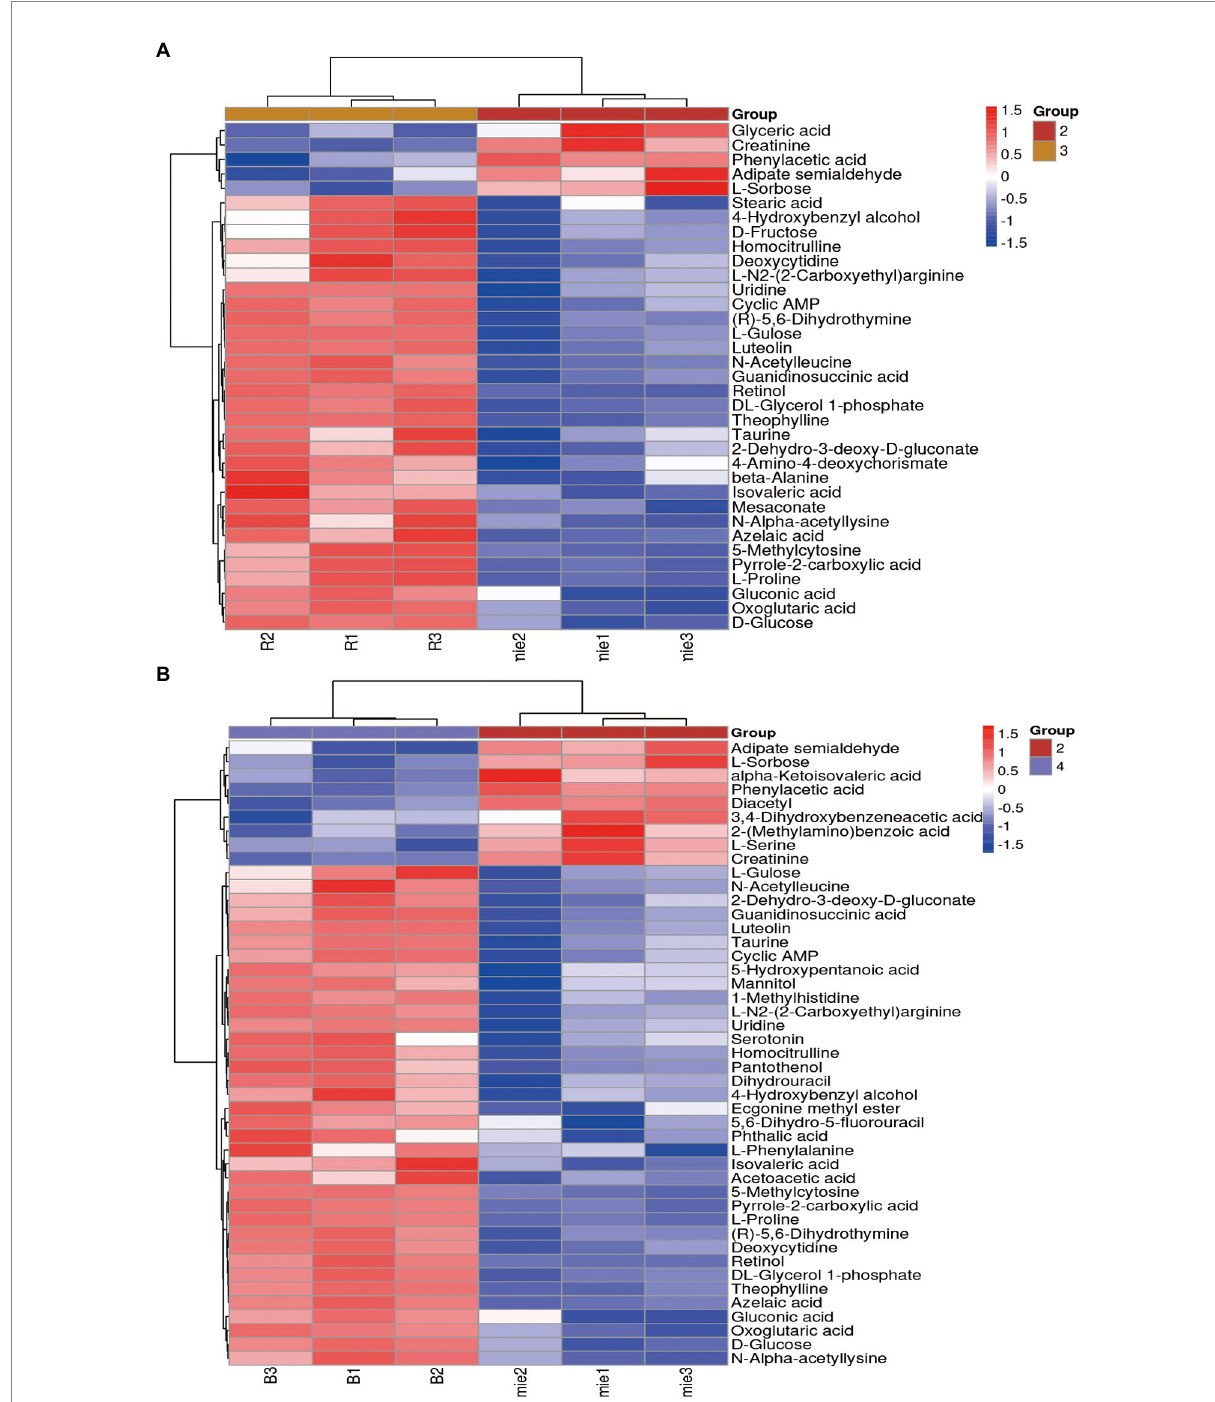
FIGURE 3 Hierarchical clustering heatmap of bacterial metabolites before and after fermentation. (A) Differential metabolites before and after fermentation of Lactobacillus plantarum R9. (B) Differential metabolites before and after fermentation of Lactobacillus gasseri B1-27. Relative contents are indicated as differences in color. The redder the color, the higher the content of the metabolite, and the bluer the color, the lower the content of the